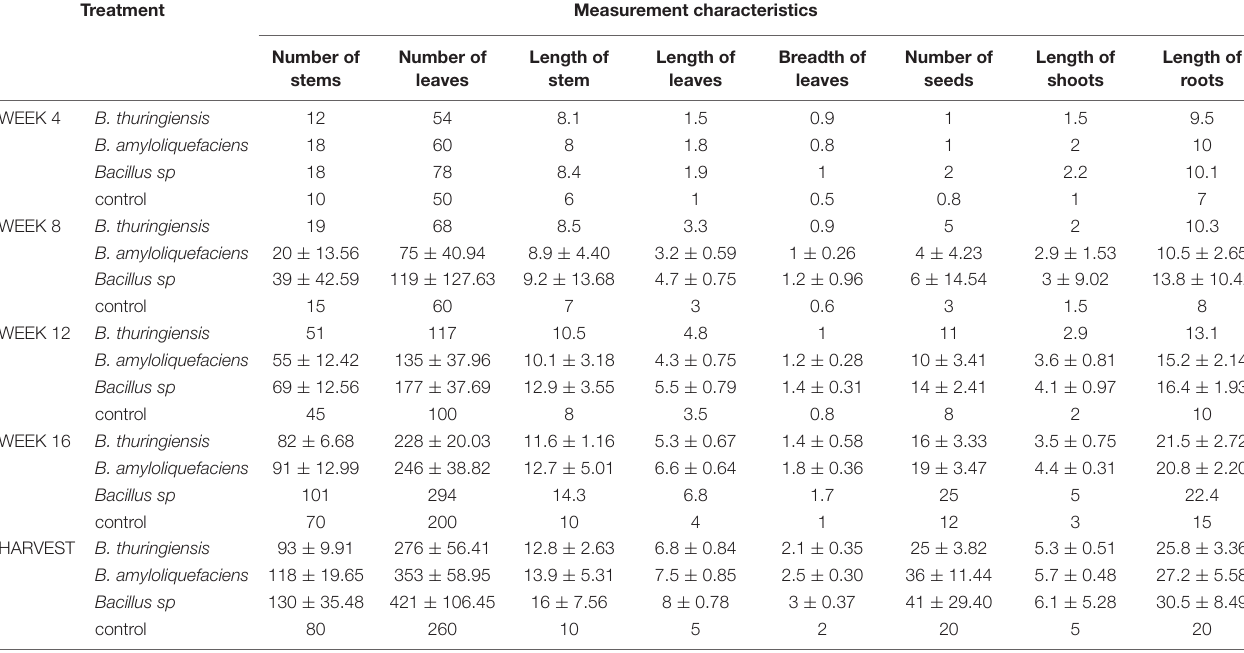
TABLE 5 | Mean measurement characteristics of the treatment per plant. Treatment Measurement characteristics